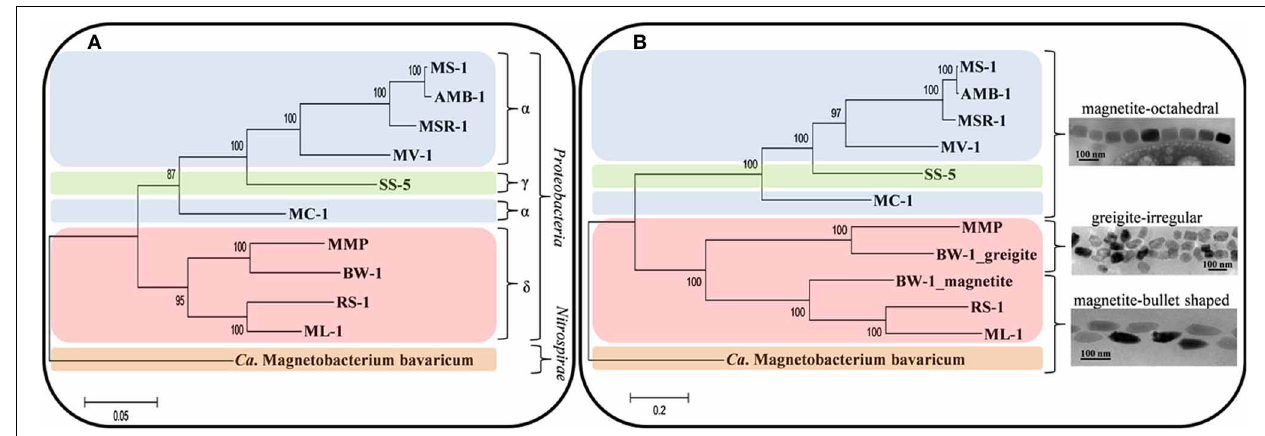
FIGURE 6 | Evolution and transfer of magnetosomes. Phylogenetic trees based on 16S rRNA gene sequences reflecting the evolution of MTB (A) and on concatenated magnetosome protein sequences (MamABEIKMPQ and FeoB) reflecting the evolution of magnetotaxis (B) . Reproduced with permission from Lefèvre et al. (2013a,b). Trees were constructed applying the maximum likelihood algorithm. Bootstrap values at nodes were calculated with 100 replicates. Magnetotactic strains